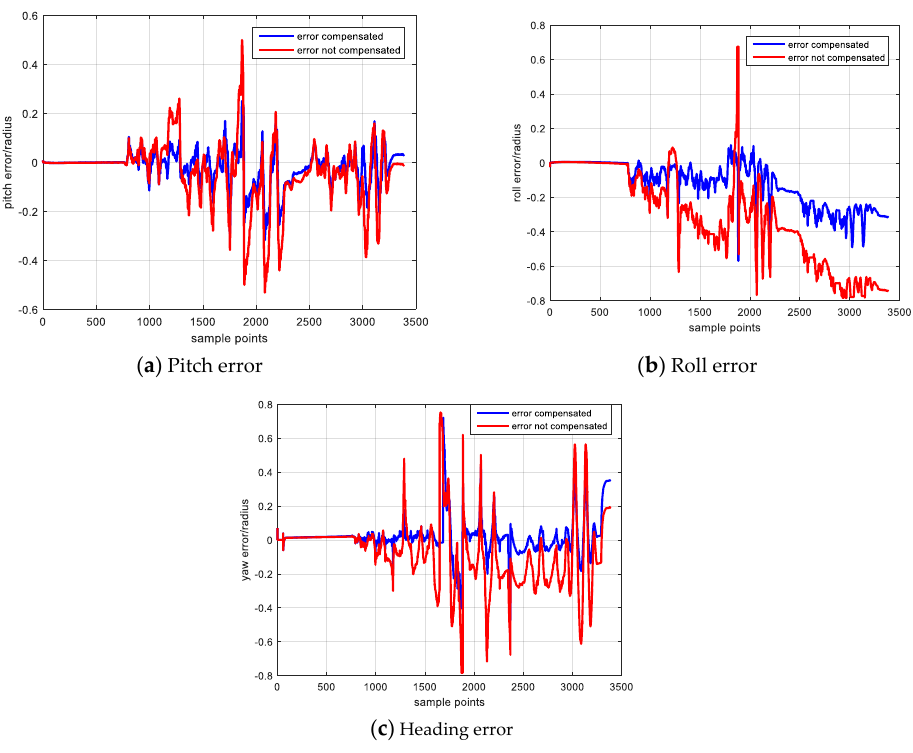
Figure 8. Attitude Calculation Result. Table 12. Statistical Error Result.